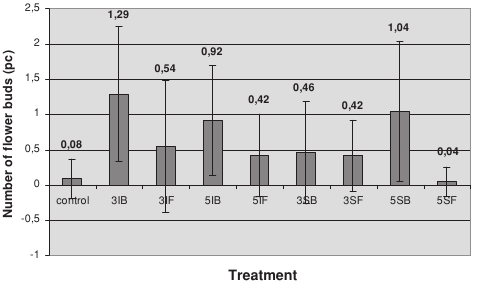
Figure 5. The effect of treatments on number of flower buds of Saintpaulia